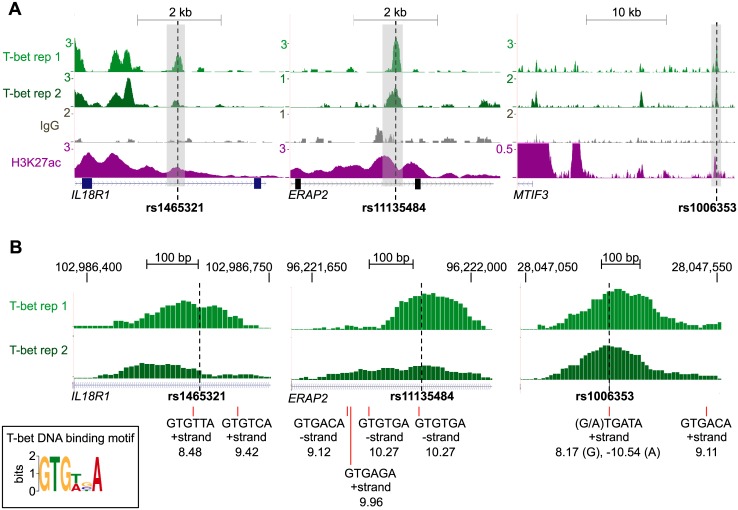
Motif analysis does not reliably predict impact on T-bet binding.A. T-bet binding, IgG control and H3K27ac modification (ChIP-seq reads/million) at the genomic regions surrounding the SNPs rs1465321 (left), rs11135484 (center) and rs1006353 (right). The location of the SNPs are indicated by dashed vertical lines. The regions highlighted in grey are expanded in B. B. Expanded view of T-bet binding at the regions highlighted in grey in A. The locations of sequences matching the identified T-bet DNA binding motif (inset) are marked by red lines, together with their score (a negative value indicates a poor match). Only rs1006353 overlaps a T-bet DNA binding motif and the A allele is predicted to disrupt the motif and T-bet binding.